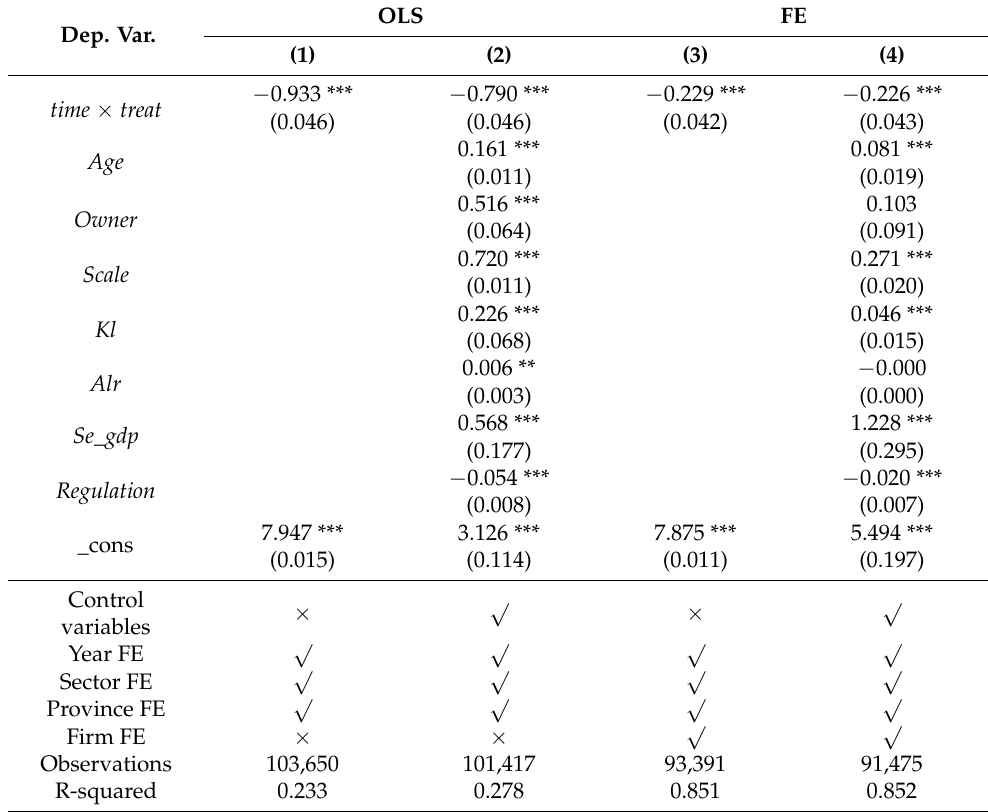
Table 12. Mechanism test of the influence of the SO 2 ETS on emissions. Dep.